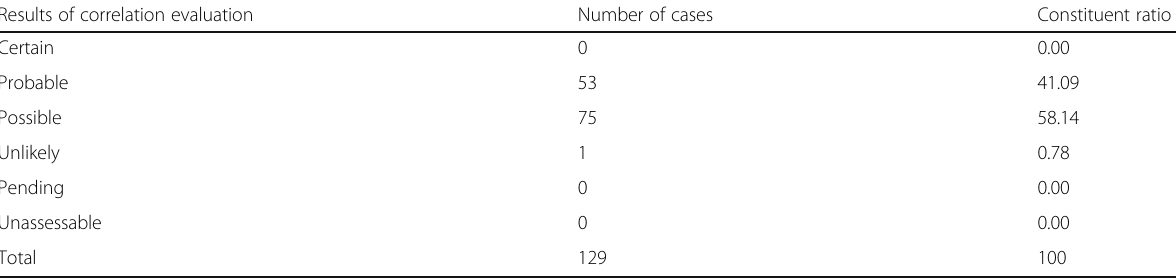
Table 2 Results of correlation evaluation between ADRs and ADEs of XSTI Results of correlation evaluation Number of